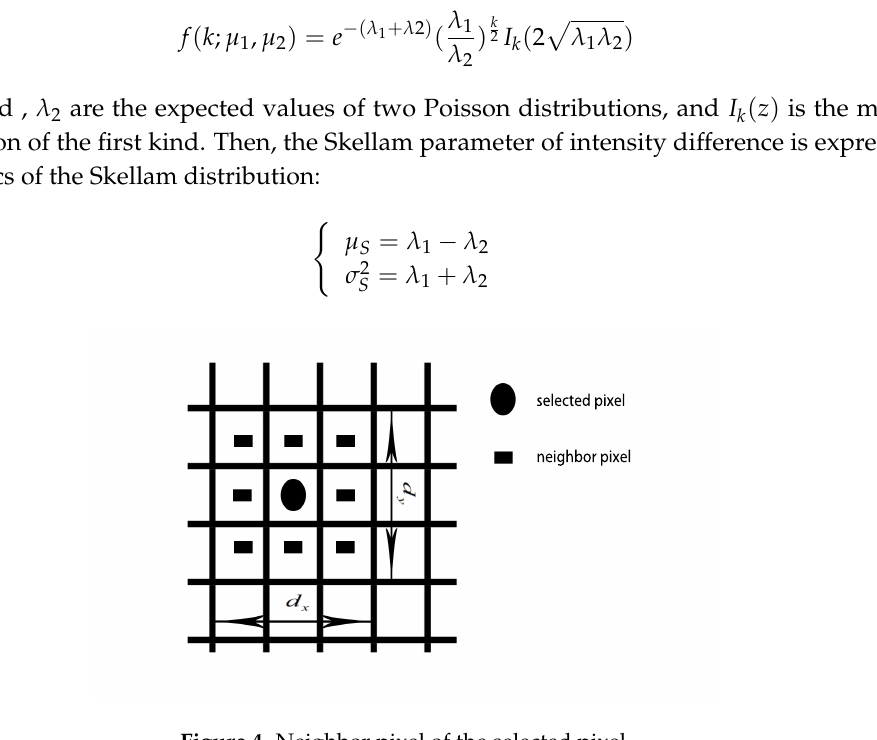
Figure 4. Neighbor pixel of the selected